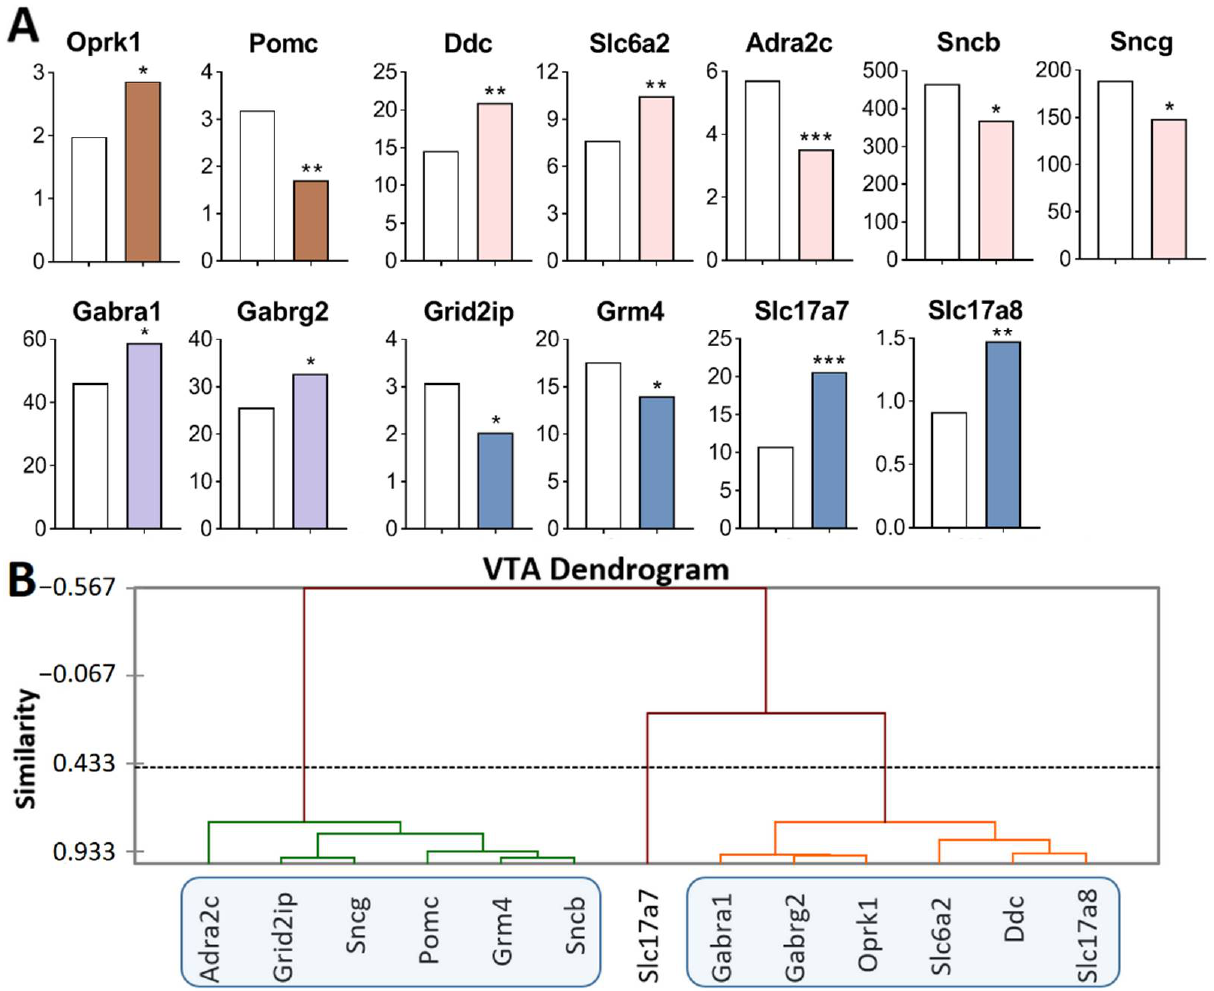
Figure 1. DEGs in the VTA of highly aggressive mice. ( A ) FPKM of the DEGs in the VTA (Supplementary Table S1). White bars—controls; colored bars—winners: brown—opioidergic genes; pink—CAergic genes; lilac—GABAergic genes; violet—glutamatergic genes. * p < 0.05; ** p < 0.01; *** p < 0.001. ( B ) AHC based on 13 reference DEGs’ expression profiles (additional information: Supplementary Table S2). Similarity: Pearson’s correlation coefficient. Agglomeration method: unweighted pair-group average. The main clusters are highlighted with a blue rounded rectangle.